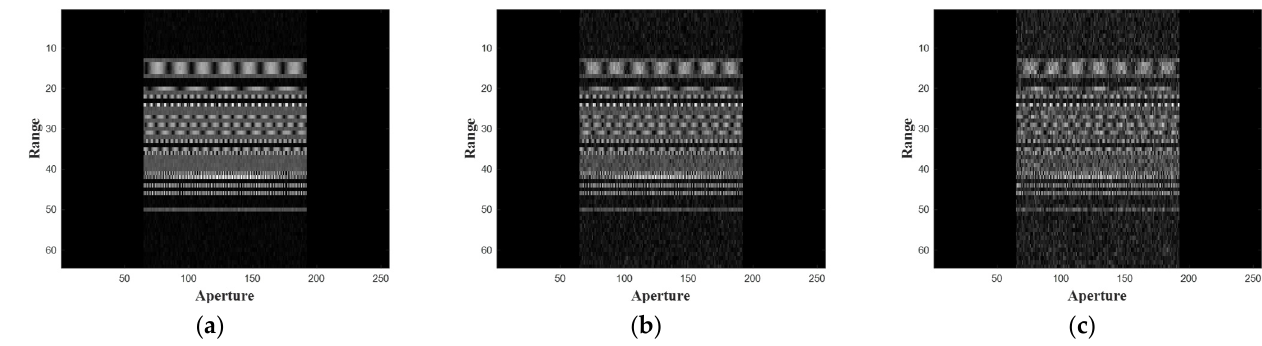
Figure 7. The range profile of the data with different SNR levels. ( a ) 20 dB. ( b ) 10 dB. ( c ) 5